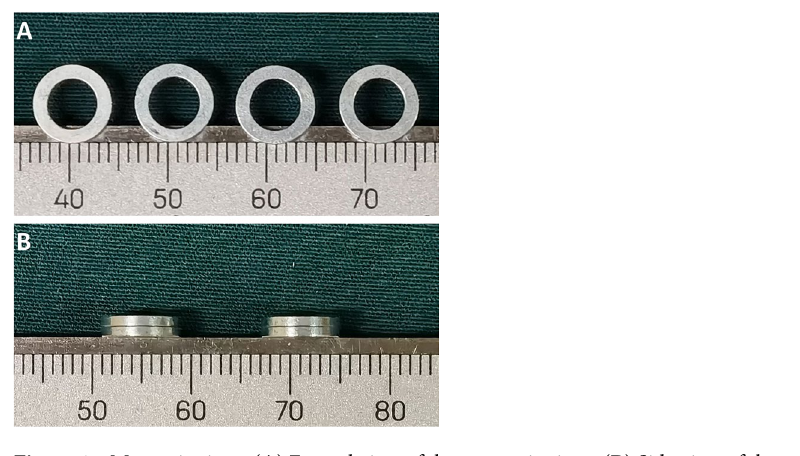
Figure 1. Magnetic rings. ( A ) Frontal view of the magnetic rings. ( B ) Side view of the magnetic rings attracted